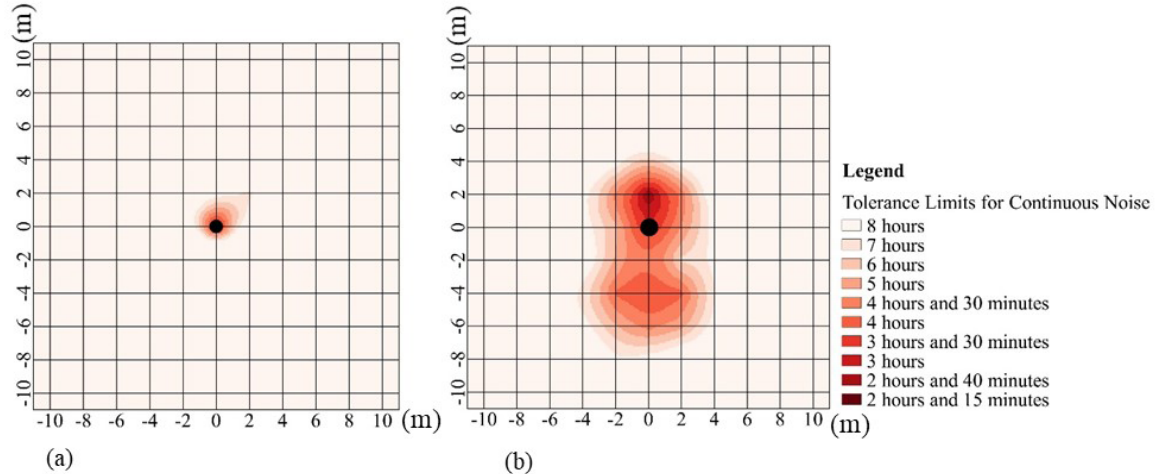
Figure 4. Map of the spatial distribution of the exposure time limits based on the noise emitted by the tractor: a) without rotary cutter activation; b) with rotary cutter activation.